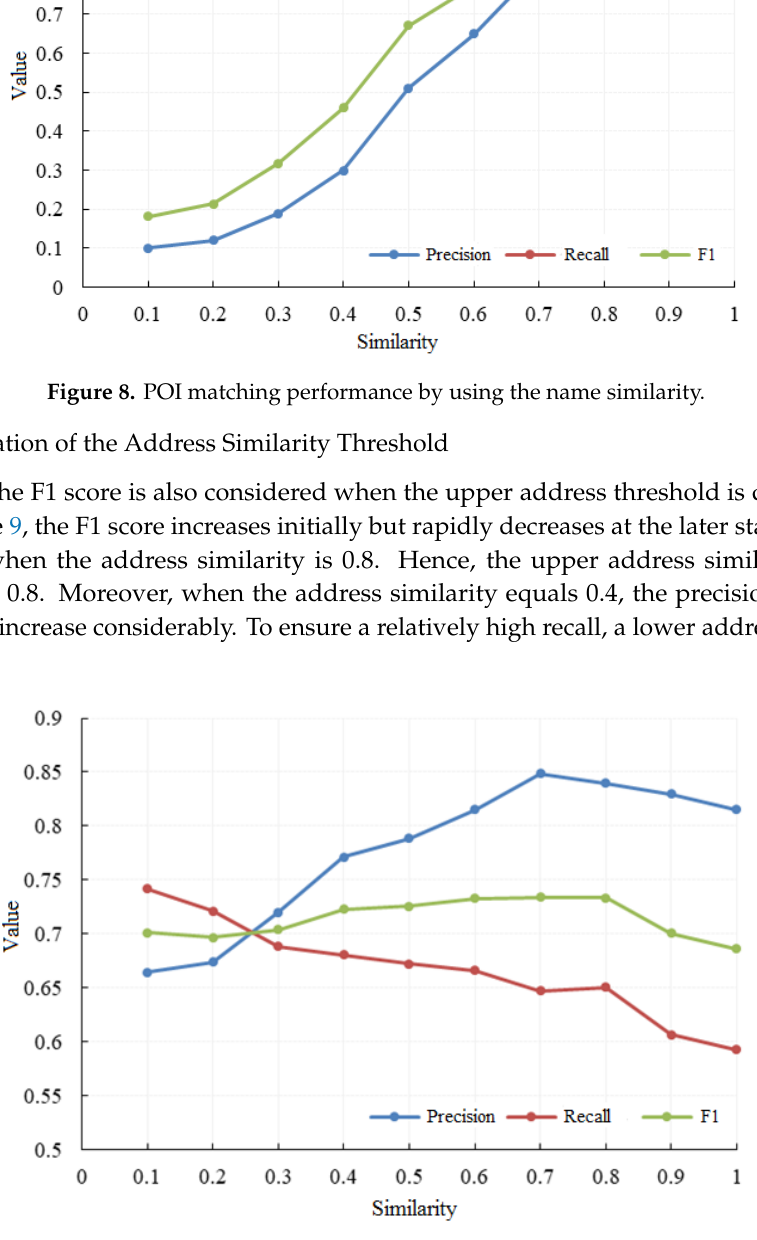
Figure 9. POI matching performance by using the address similarity.